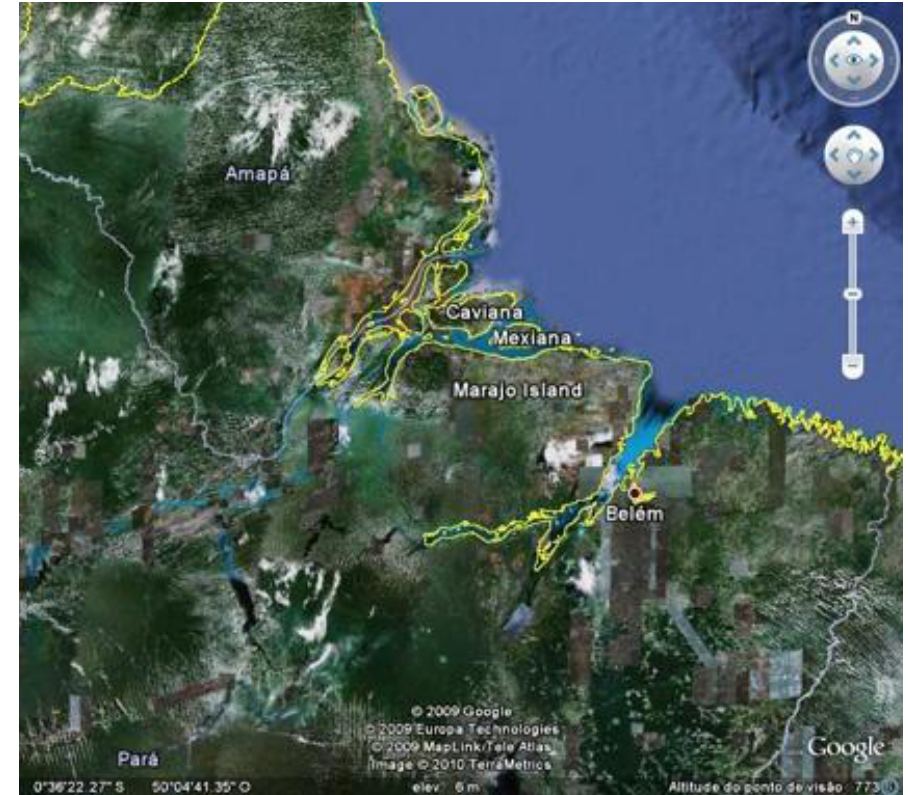
Figure 1. Google Earth satellite image of the mouth of the Amazon River, showing Marajó, Caviana and Mexiana